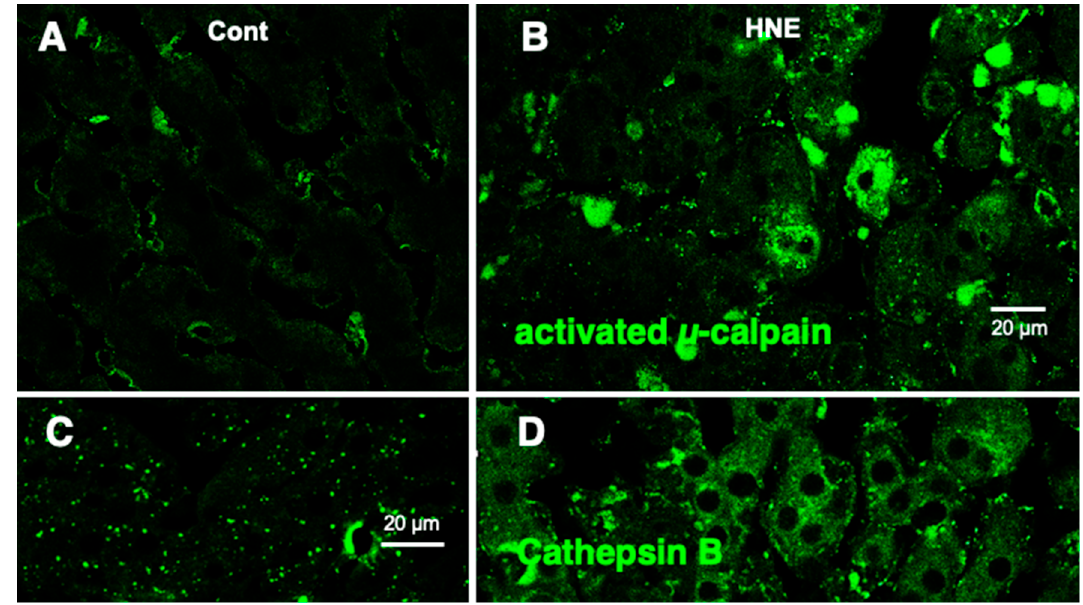
Figure 6. Immunofluorescence histochemical staining of activated μ -calpain ( A , B ) and cathepsin B ( C , D ). Compared to the control livers (( A ), Cont), the livers after hydroxynonenal injections (( B ), HNE) exhibited an increased immunoreactivity of activated μ -calpain in the hepatocytes. Concomitantly, coarse granular and diffuse cytoplasmic cathepsin B immunoreactivity was seen after the hydroxynonenal injections (( D ), HNE), which is in marked contrast to the control (( C ), Cont). This indicates extra-lysosomal leakage of cathepsin B, which was localized within the lysosomes prior to hydroxynonenal injections (( C ), Cont).